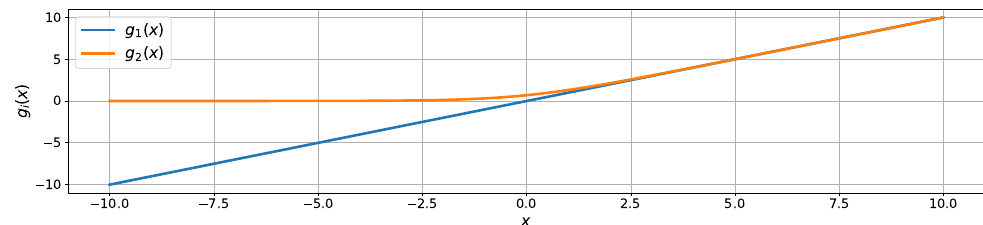
Figure 5. Link functions used in the estimation of distribution